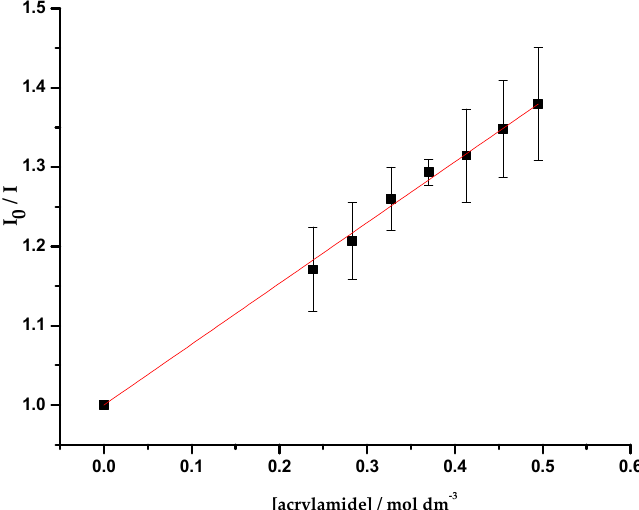
Figure 4. Plot of I 0 / I vs. acrylamide concentration ([acrylamide]), determined for the quenching of OmpF WT/ E. coli total lipid extract liposomes by acrylamide, with excitation and emission wavelengths of 290 and 320 nm, respectively. Equation (6) was fitted to the experimental data. Data points are the mean of, at least, three independent experiments. Error bars are the SD.